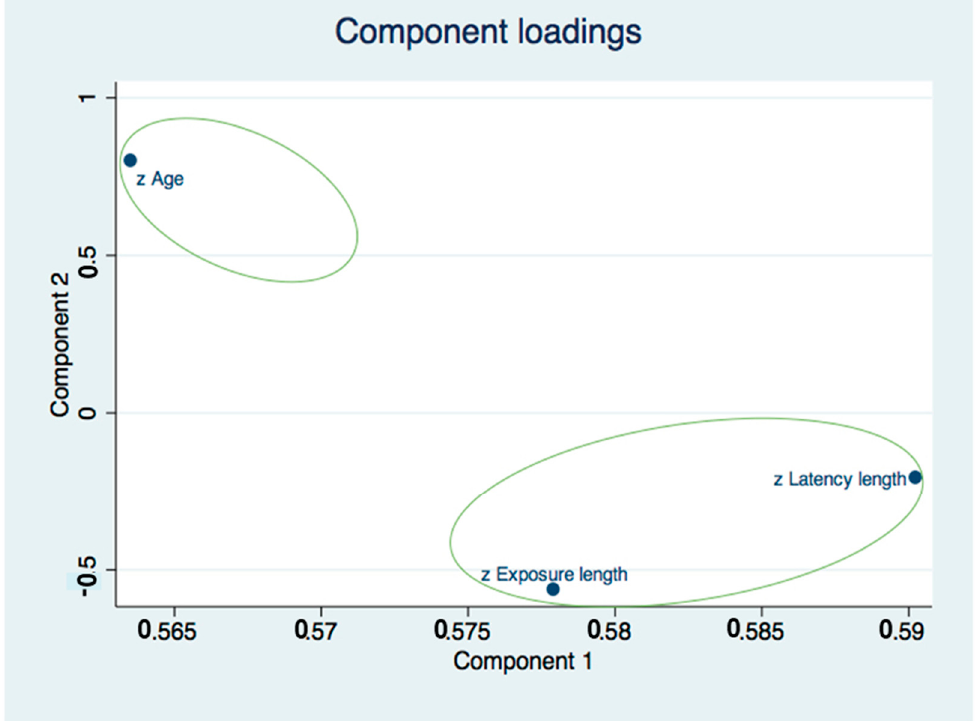
Figure 3. Component loading plot demonstrating two main components. Two main components are present: the first of the age variable and the second of the time related variables (exposure length and latency length).